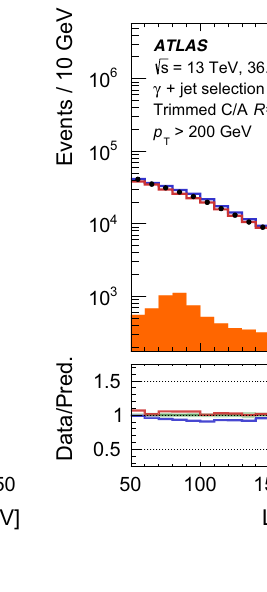
beside the specific sample to which it applies. Systematic uncertainties are indicated as a band in the lower panel and include all experimental uncertainties related to the selection of events, as well as the reconstruc- tion and calibration of the large- R